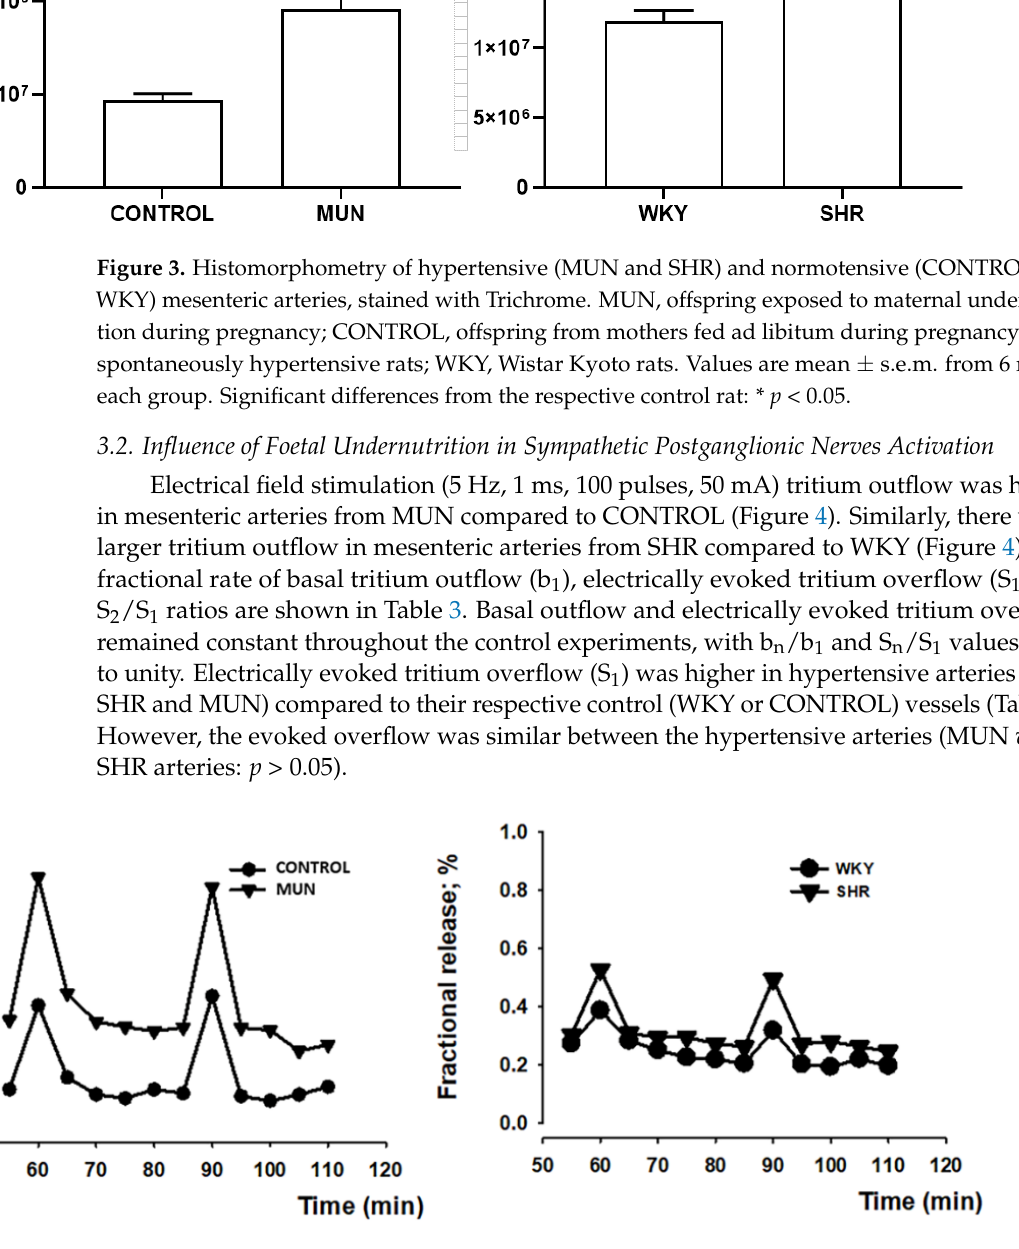
Figure 4. Representative examples of time course tritium outflow from: mesenteric arteries from normotensive animals, CONTROL (circles, left panel) and WKY (circles, right panel), and hyperten- sive animals, MUN (triangles, left panel) and SHR (triangles, right panel) from typical experiments. After pre-incubation with [ 3 H]-noradrenaline, tissues were superfused with [ 3 H]-noradrenaline-free medium containing desipramine (400 nM). Tritium outflow (ordinates) is expressed as a percentage of the total radioactivity present in the tissue at the beginning of the collection period and was measured in samples collected every 5 min. Artery segments were stimulated twice by 100 pulses/5 Hz, (S 1 , S 2 ). Each line represents the outflow of tritium from a single superfusion chamber; MUN, offspring exposed to maternal undernutrition during pregnancy; CONTROL, offspring from mothers fed ad libitum during pregnancy; SHR, spontaneously hypertensive rats; WKY, Wistar Kyoto rats.